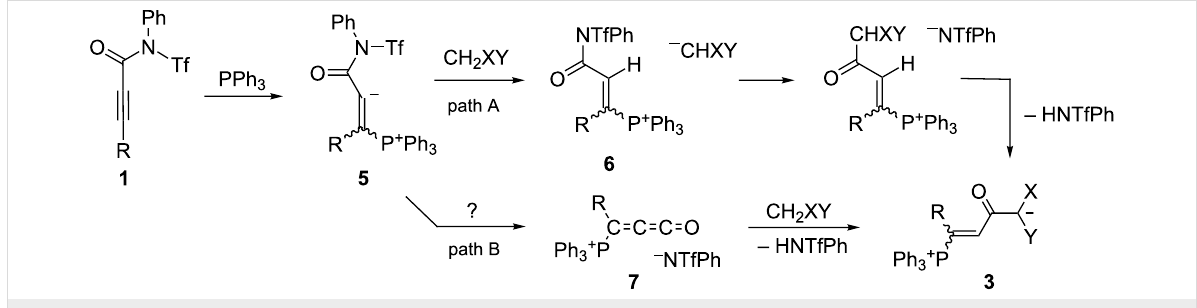
the N -phenyltriflamide group by the conjugate base of the active methylene compound followed by deprotonation of the CHXY group converts 6 into the final betaine 3